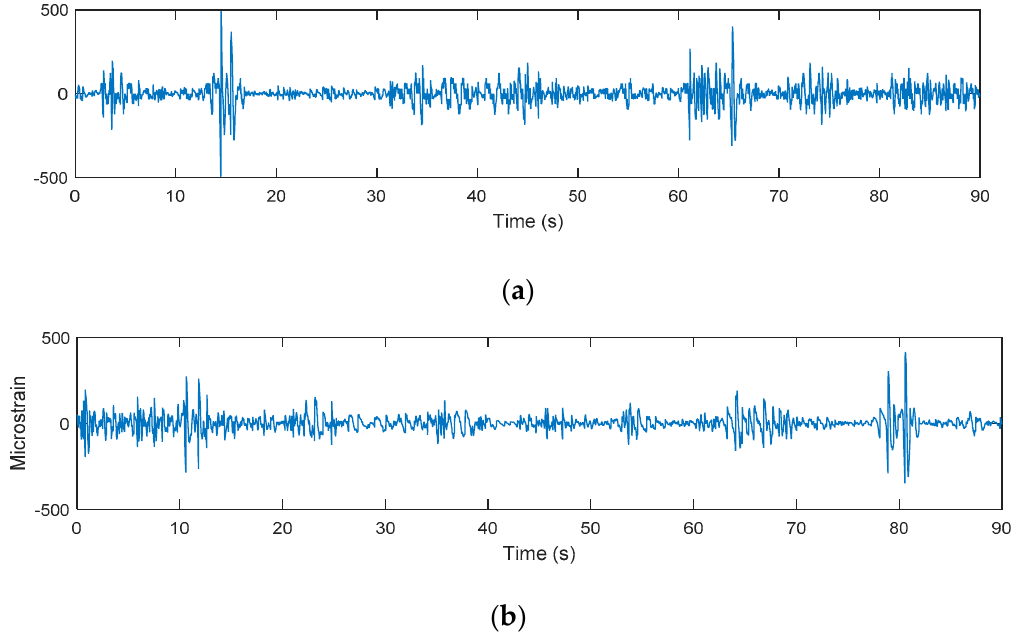
Figure 15. Lower arm acceleration signals: ( a ) Campus A, ( b ) Campus B.